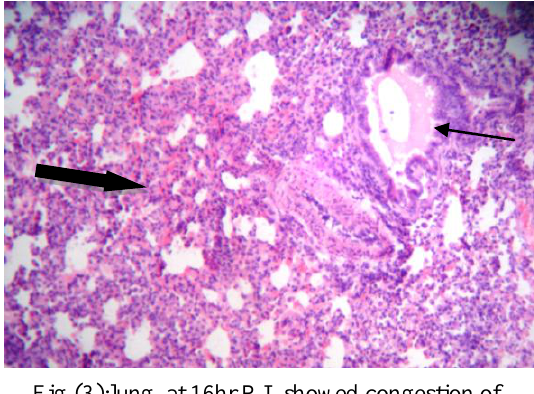
Fig (3):lung at 16hr P.I. showed congestion of the capillaries ( )with odema in the lumen( ) ( H&EX10).